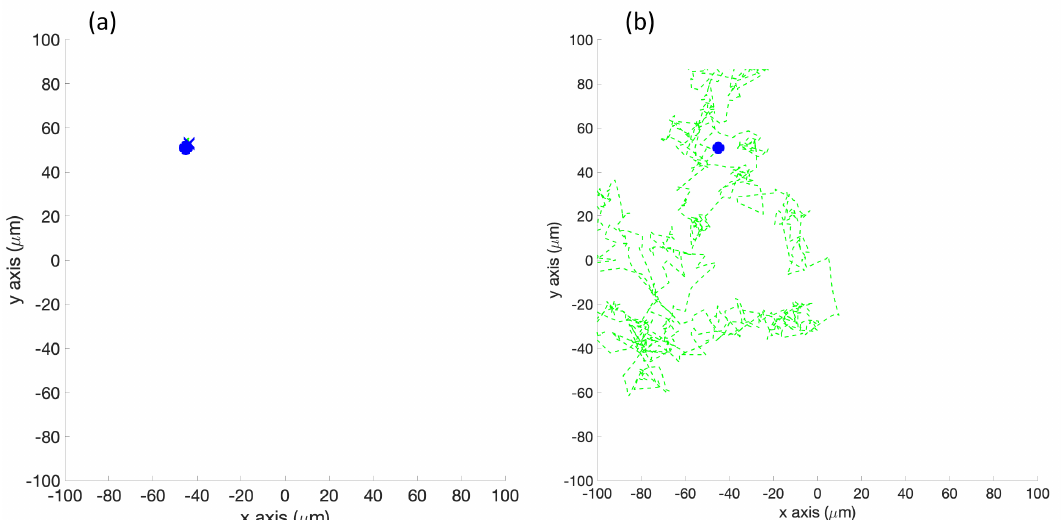
Figure 16. Case 7: With obstacles, in the homogeneous/no effluent environment, typical trajectories of the simulated robot running ( a ) the basic chemotaxis controller, and ( b ) the RapidCell chemotaxis controller. In each trajectory, the initial position is shown as a blue circle and the terminal position is shown as a blue “X”. Positions corresponding to concentrations less than 1m M are shown in dashed green, otherwise shown in red.